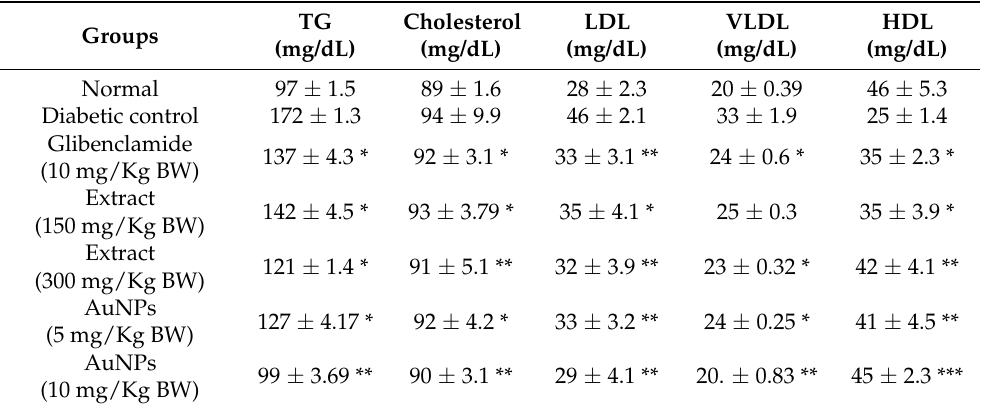
Table 11. Effect of methanol extract and AuNPs on HDL cholesterol, triglycerides, total cholesterol, LDL cholesterol and serum VLDL